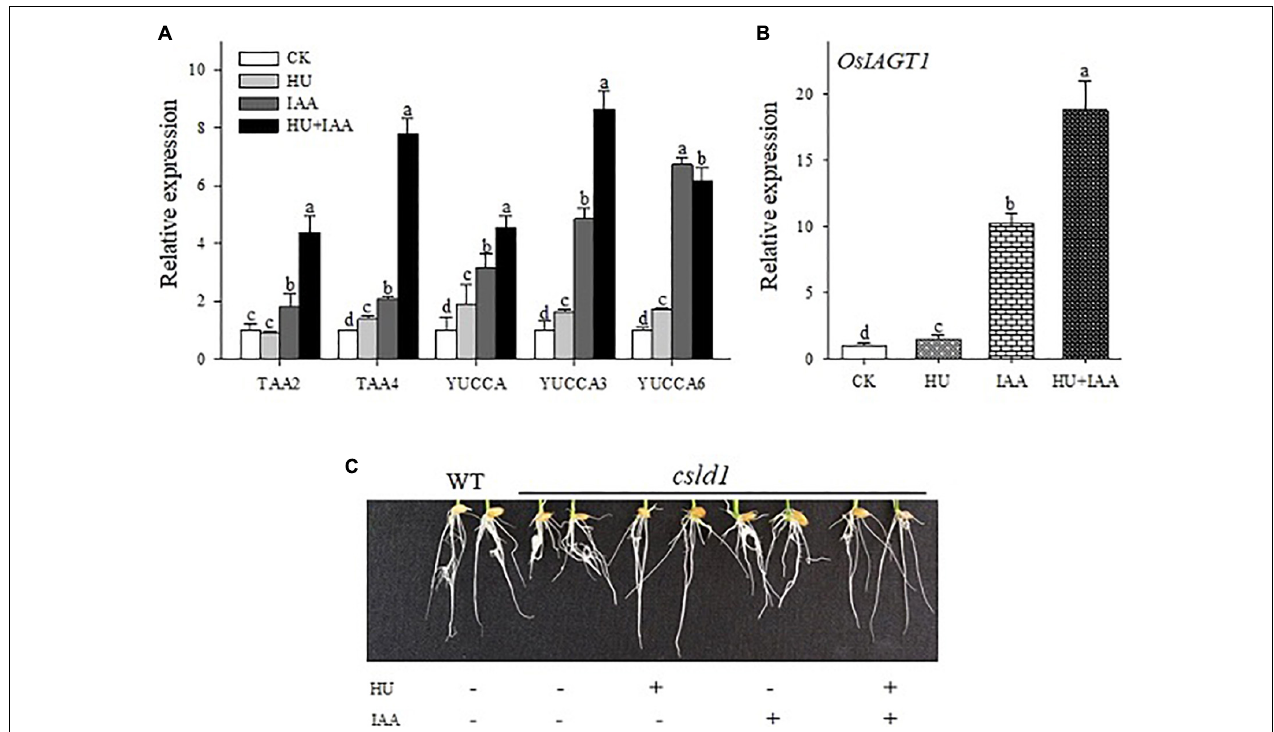
FIGURE 7 | Transcript level analysis of auxin biosynthesis (A) and IAA glycosyltransferase (OsIAGT1) marker genes (B ). Effect of HU, IAA, and their combination treatment on the putative glycosylation CSLD1 mutant seedling grown for 5 days in a nutrient medium (C) . Different letters indicate significant differences between treatments, tested by one-way ANOVA followed by Fisher’s test ( n = 3, p < 0.05). CK, Control; HU, Hydroxyurea; IAA, indole-3-acetic acid. TABLE 1 | Quantification of plant hormones in rice plants treated with IAA, HU, and their combination. S.